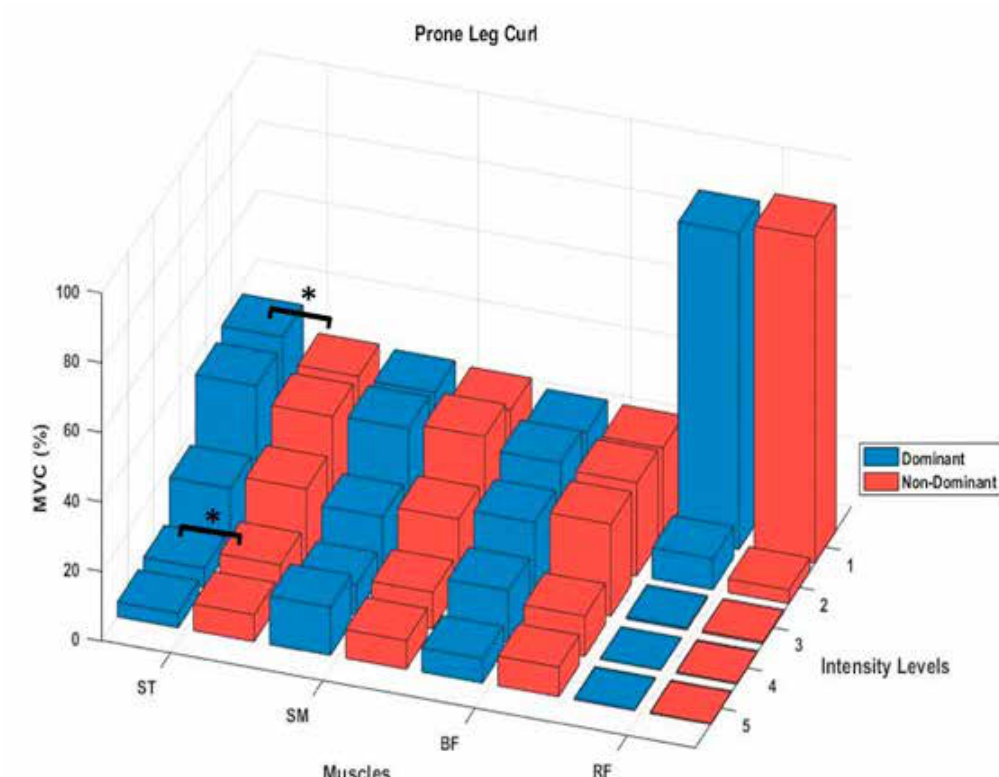
Figure 8. Comparison of activity rates of D and ND legs in the five intensity zones for the PLC exercise * Symbol refers to the significance of the difference between the D leg and ND leg (p<0.05). ST: Semitendinosus, SM: Semimembranosus, BF: Biceps femoris, RF: Rectus femoris